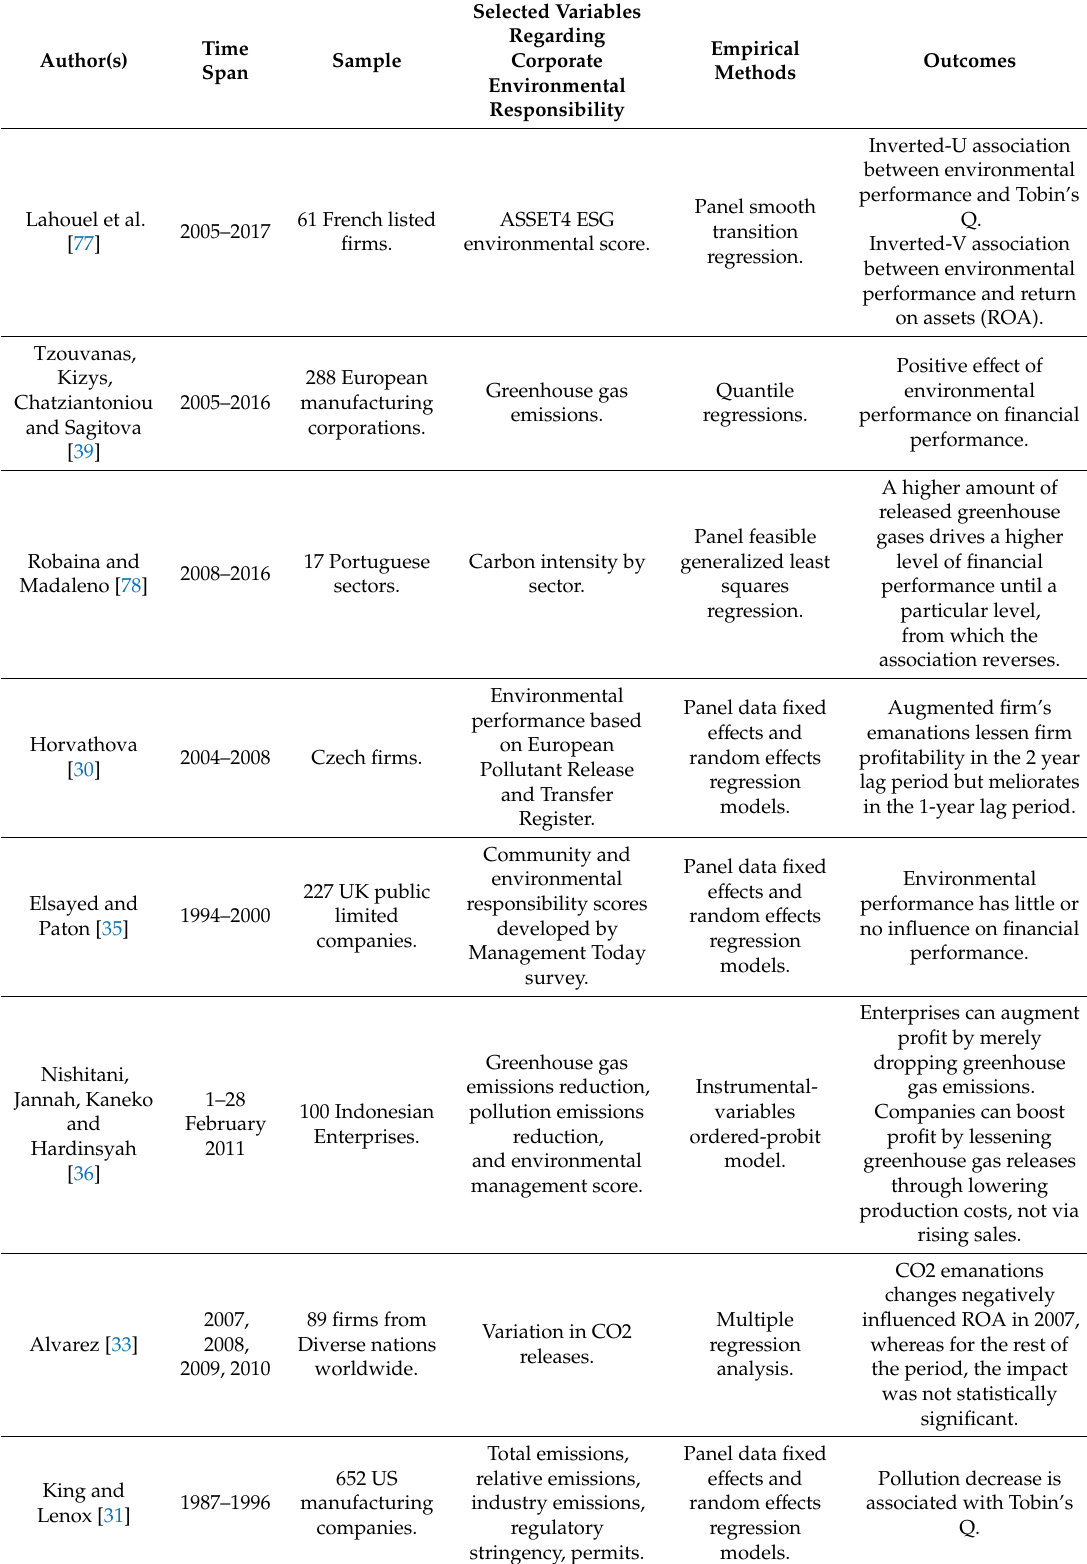
Table 1. Prior studies regarding the corporate environmental responsibility–corporate financial performance